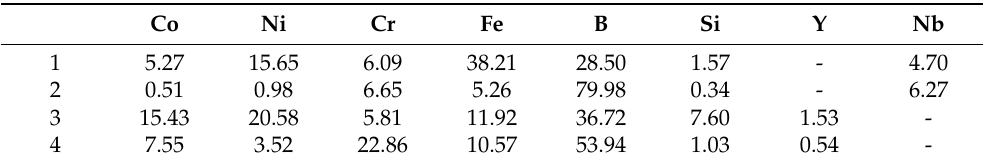
Figure 2. Surface and cross-sectional morphologies of ( a , b ) FeCoNiCrBSiNb powder and ( c , d ) FeCoNiCrBSiY powder. (The positions 1, 2, 3 and 4 marked in the figure are the positions for energy spectrum analysis). Table 4. Chemical compositions of the powders obtained by EDS analysis at the marked positions in Figure 2b,d